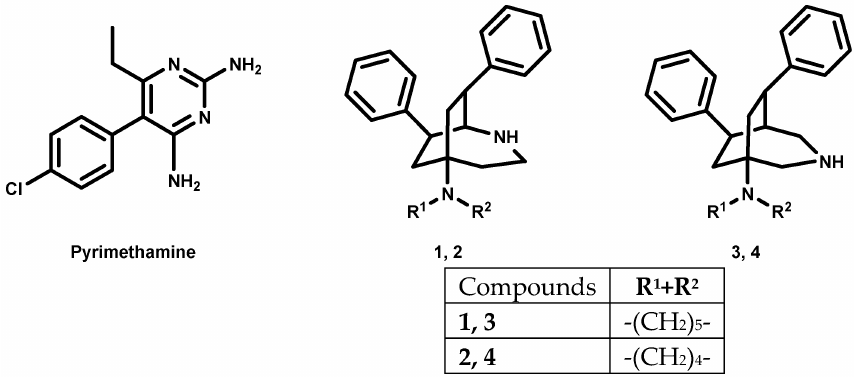
Figure 1. Pyrimethamine, 2-azabicyclo[3.2.2]nonanes and 3-azabicyclo[3.2.2]nonanes. The 2-azabicyclo[3.2.2]nonanes 1, 2 and the 3-azabicyclo[3.2.2]nonane 3, 4 show an- tiplasmodial activity in submicromolar concentration. Their antitrypanosomal activity requires low micromolar concentrations